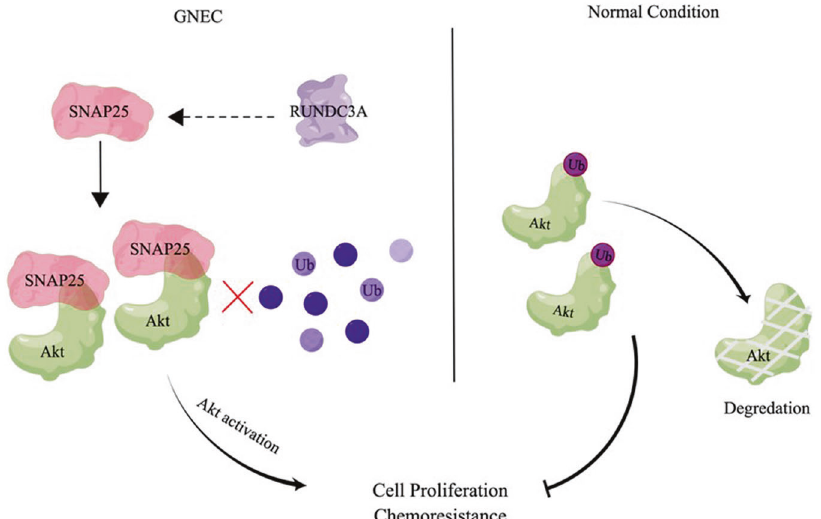
Fig. 1 Schematic representation for the mechanism of RUN Domain Containing 3A (RUNDC3A)/Synaptosomal-Associated Protein 25 kDa (SNAP25)/Akt axis. The mechanism of RUNDC3A/SNAP25/Akt axis serves as a switch that regulates Akt activation in gastric neuroendocrine carcinoma (GNEC) progression and chemoresistance by stabilizing cytoplasmic Akt. The curve arrows shown in the diagram indicate as positive effect, and the curve T-shaped line indicates as inhibitory effect. See text for further details, as well as the original study by Chen and colleagues